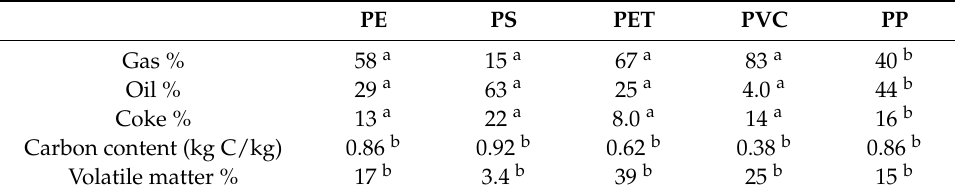
Table 10. Product yields of plastics in coke oven (%) at ≈ 1010 ◦ C [25].